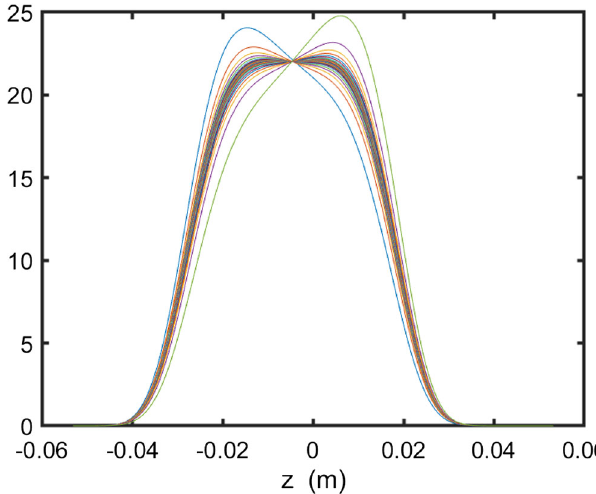
FIG. 14. A train of 26 with the charge distribution of Eq. (82), 13 . b ¼ 1 . 7 , and n g ¼